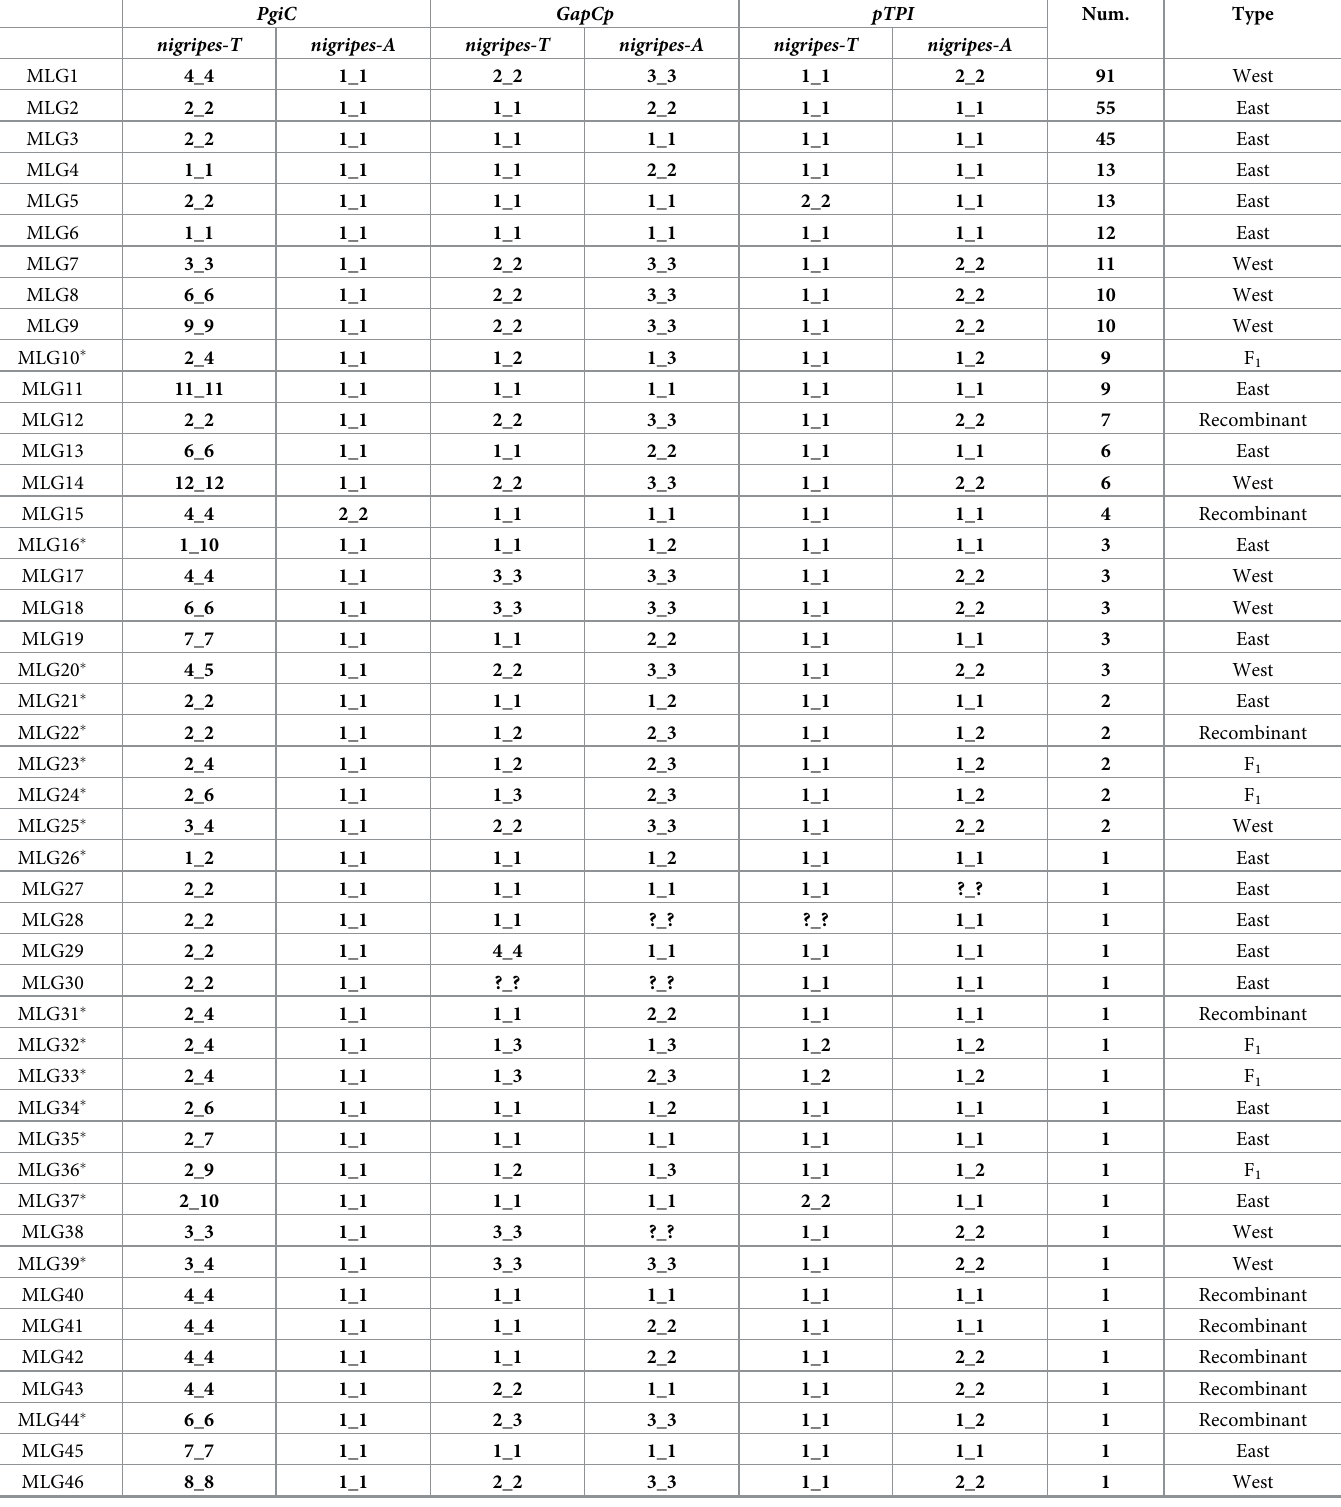
Table 4. Multi-locus genotypes of Lepisorus nigripes in this study.